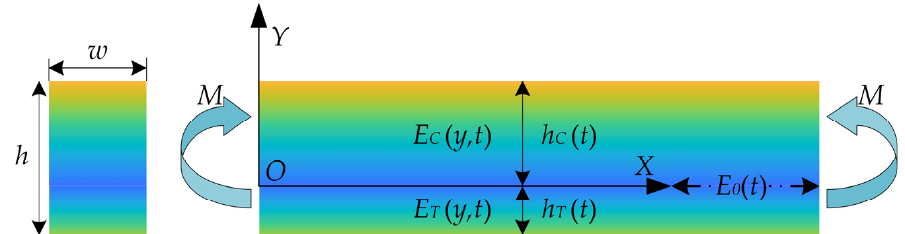
Figure 6. The schematic of a bimodular functionally graded material (FGM) under pure bending. At present, the quadratic and exponential functions are generally used for exploring the elastic modulus variation of the functionally gradient beam under pure bending action.